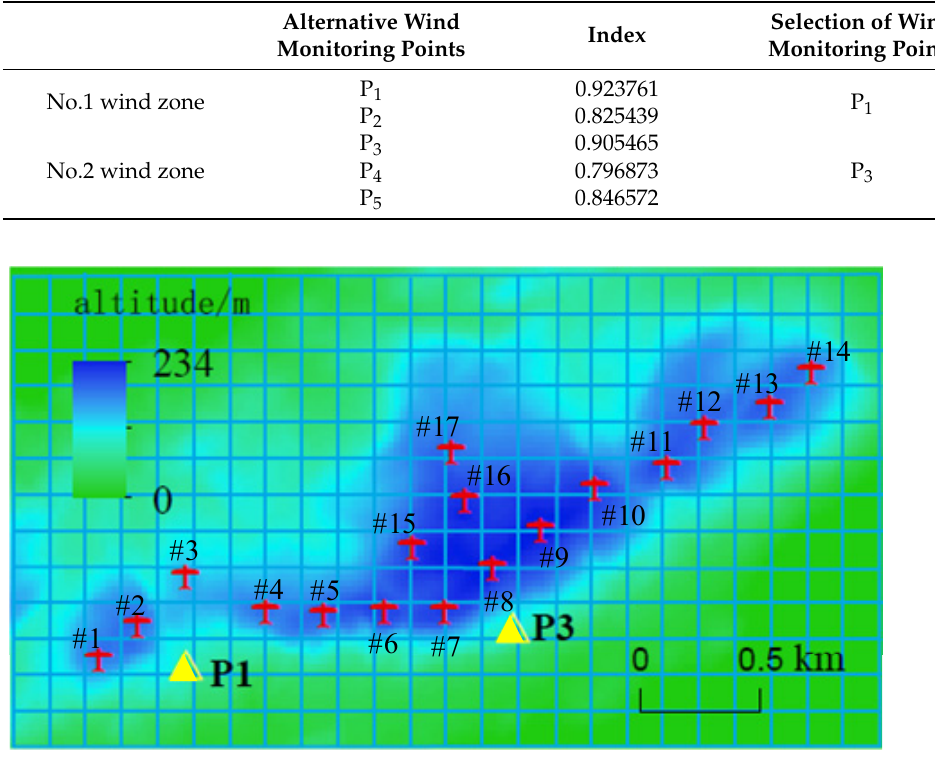
Figure 12. Optimal location of wind monitoring point. Table 4. Annual energy production and error analysis of wind